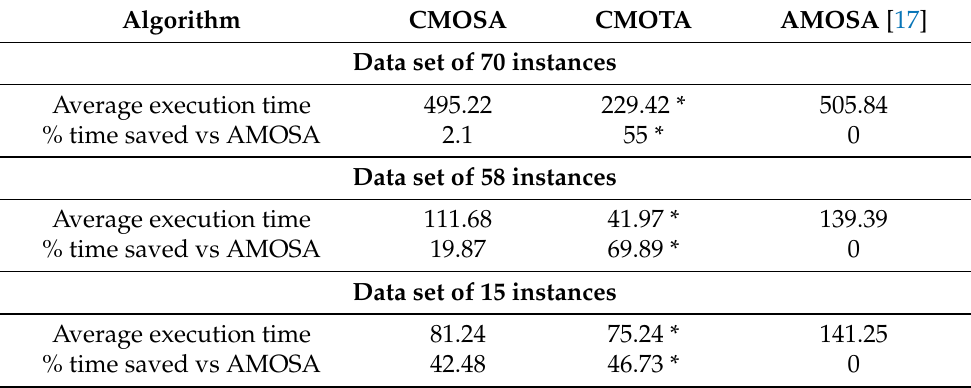
Table 11. Runtimes for CMOSA, CMOTA and